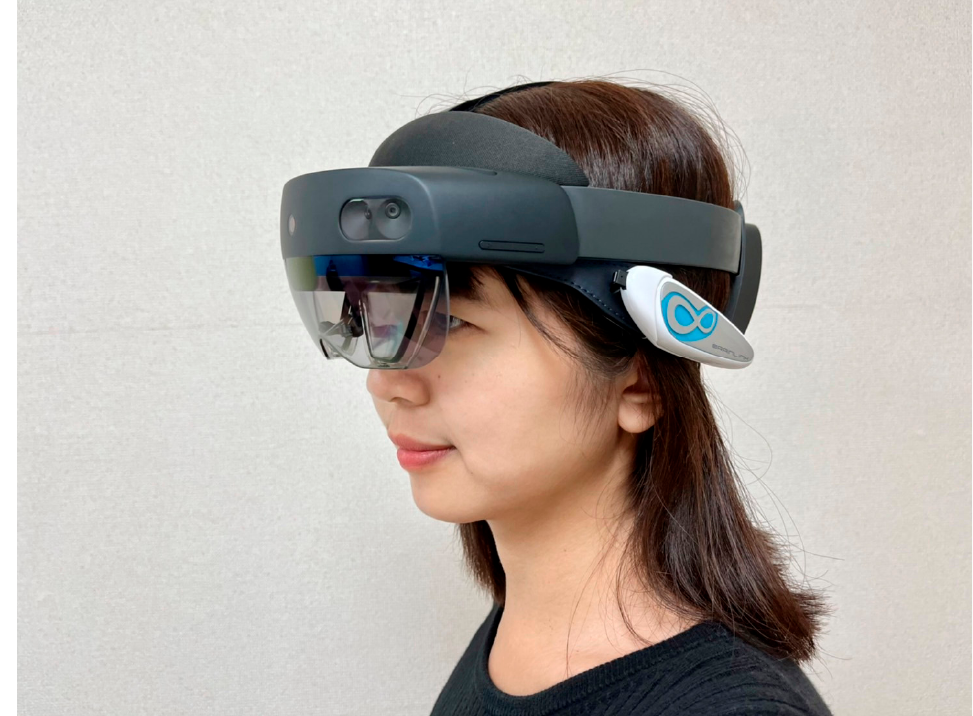
Figure 2. The participant wore HoloLens 2 and BrainLink lite.